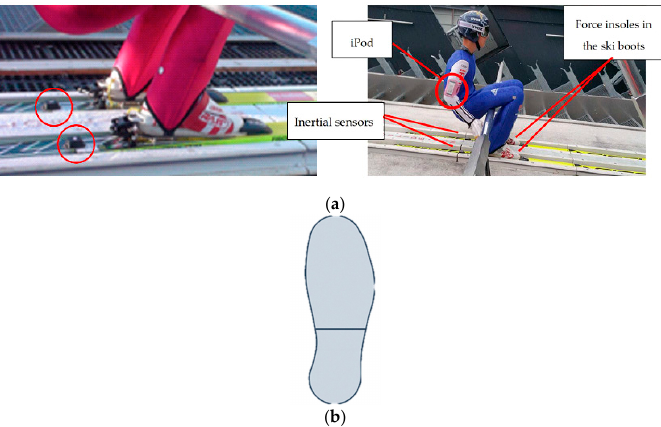
Figure 1. ( a ) Placement of the iPod case, force insoles, and inertial sensors on a subject; ( b ) Detecting area division of the fore and rear foot part in loadsol force insole (adapted from